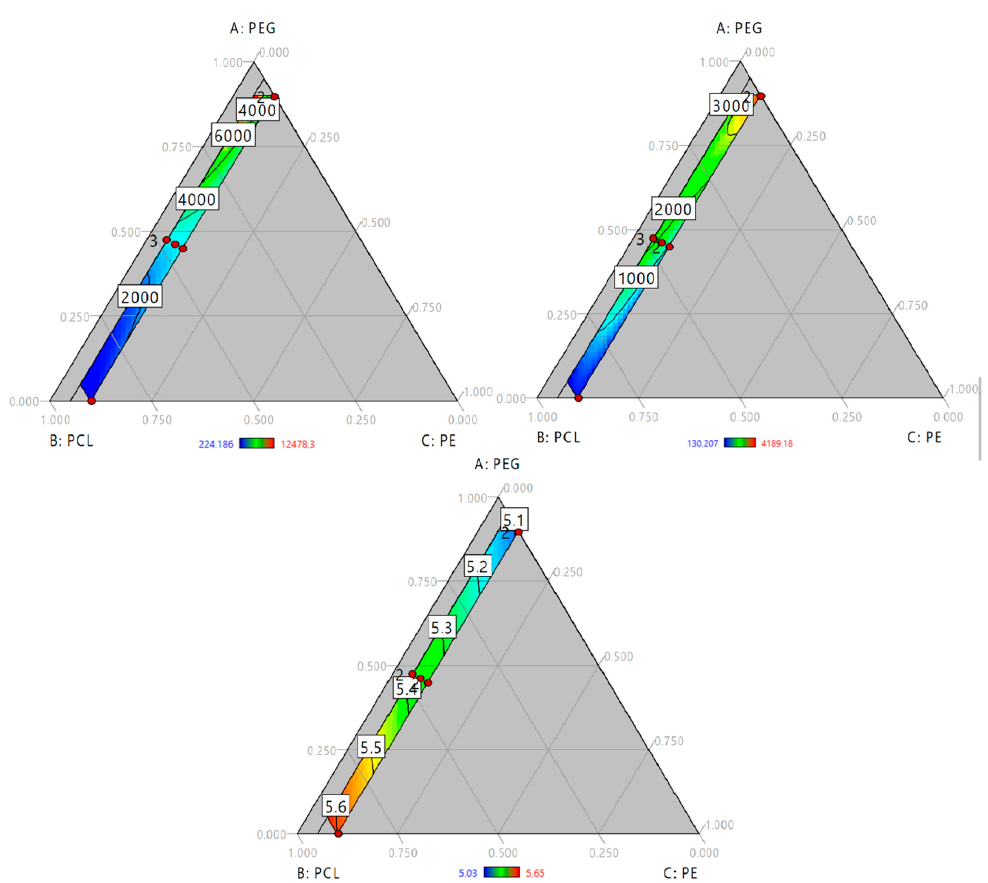
Figure 3. Ternary contour plot of area under the curve of ( A ) Water absorption kinetics (h), ( B ) hydrolytic degradation kinetics (h) and ( C ) First derivate of thermogravimetric analysis (1/°C).